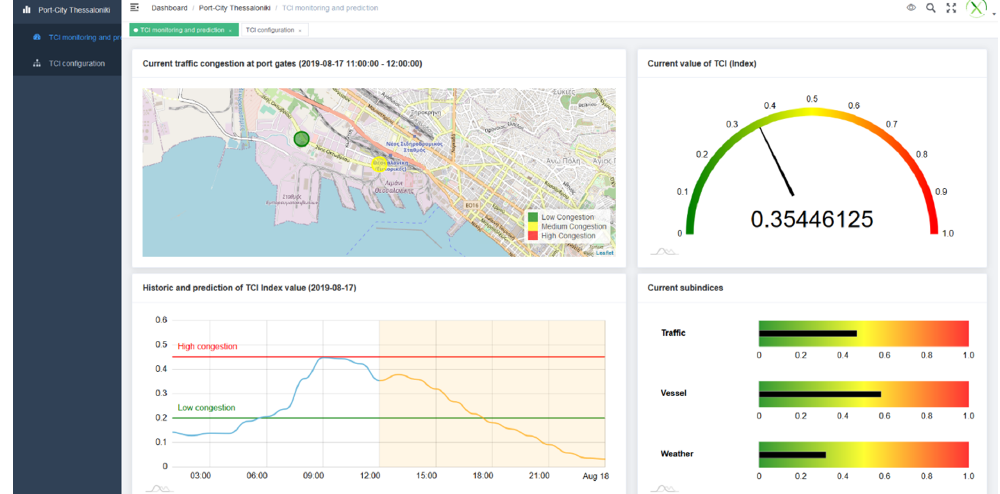
Figure A9. Visualization of the scenario 2.3 in the UI dashboard.